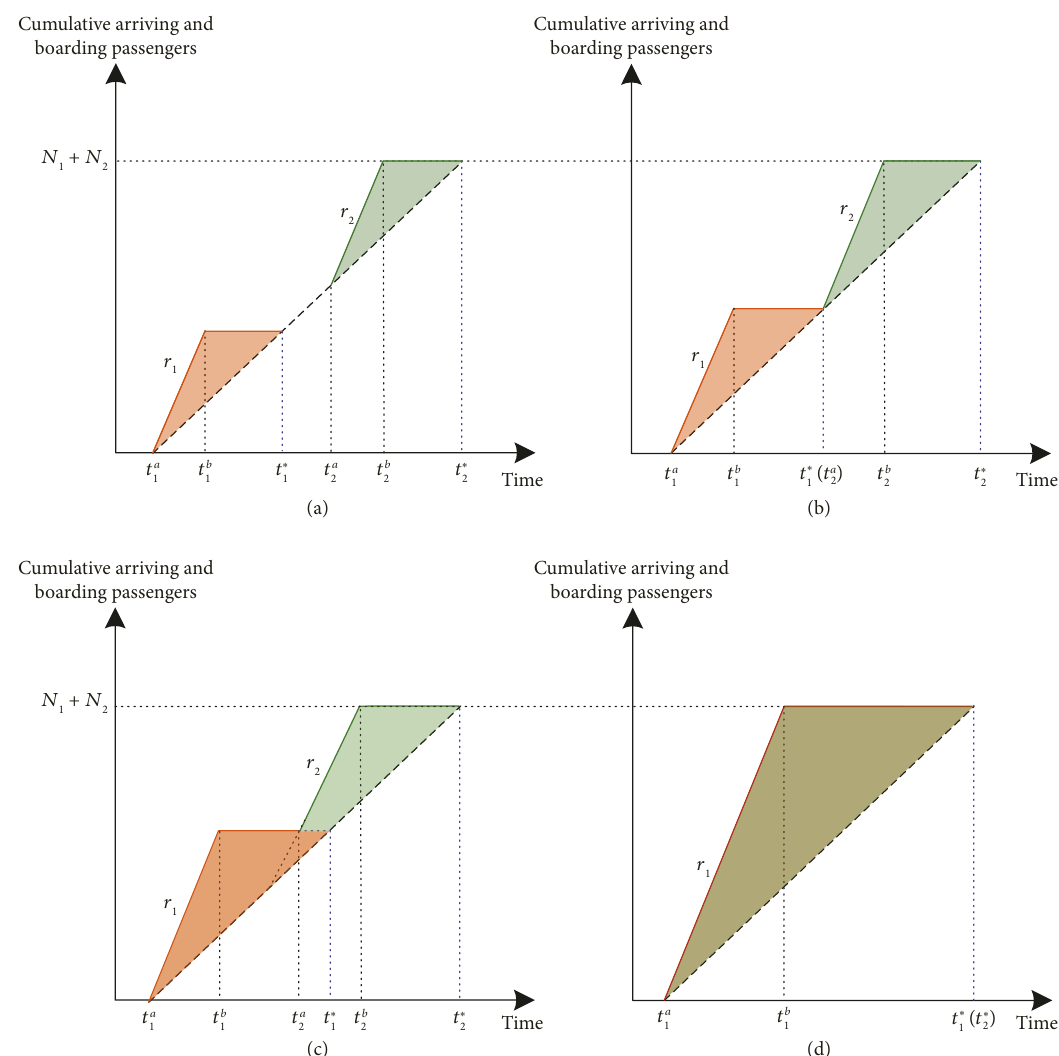
Figure 2: All equilibrium patterns of the boarding model with no-fare differentials. (a) Cumulative arriving and boarding passengers. (b) Cumulative arriving and boarding passengers. (c) Cumulative arriving and boarding passengers. (d) Cumulative arriving and boarding